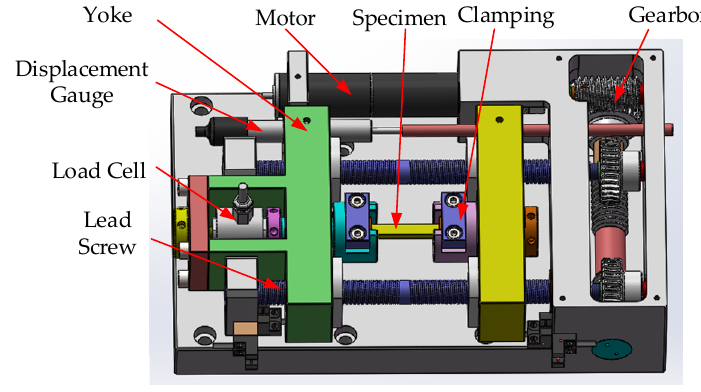
Figure 2. Elements of the micro tensile machine. Table 1. Main performance parameters of the tensile